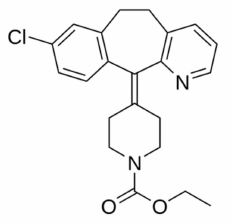
Figure 4. Loratadine structure.